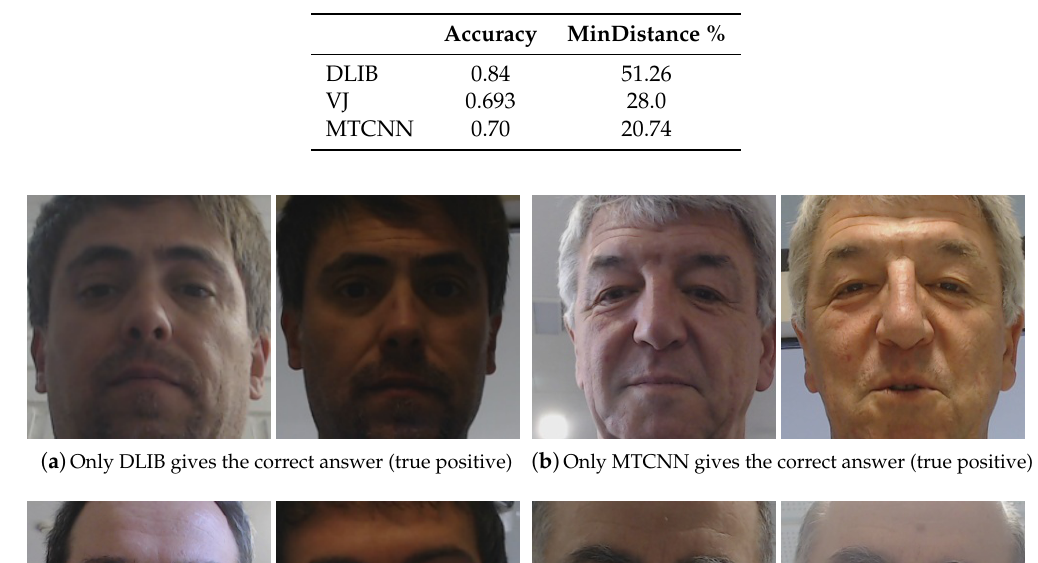
Table 6. Performance values of each method individually.